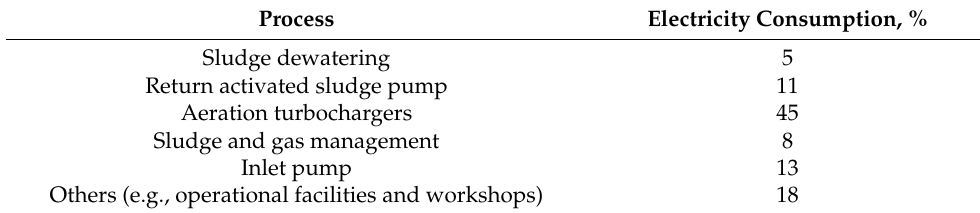
Table 3. Example of the proportions of electricity consumption of a